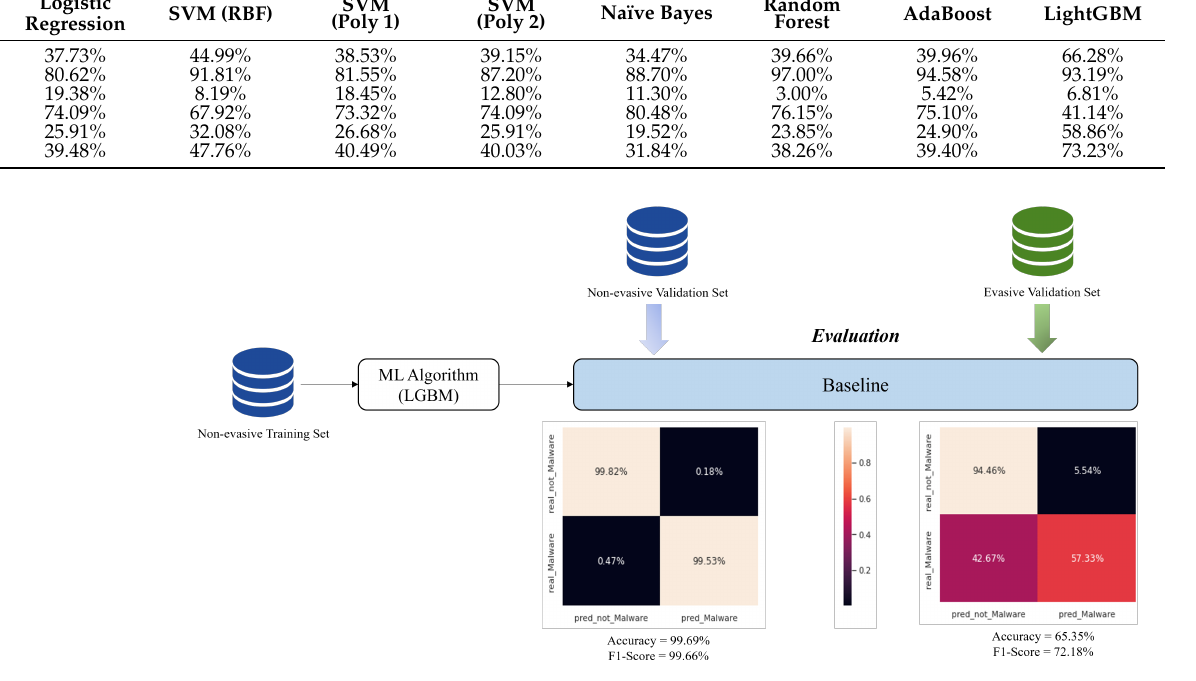
Figure 4. Performance of the baseline on the non-evasive and evasive validation